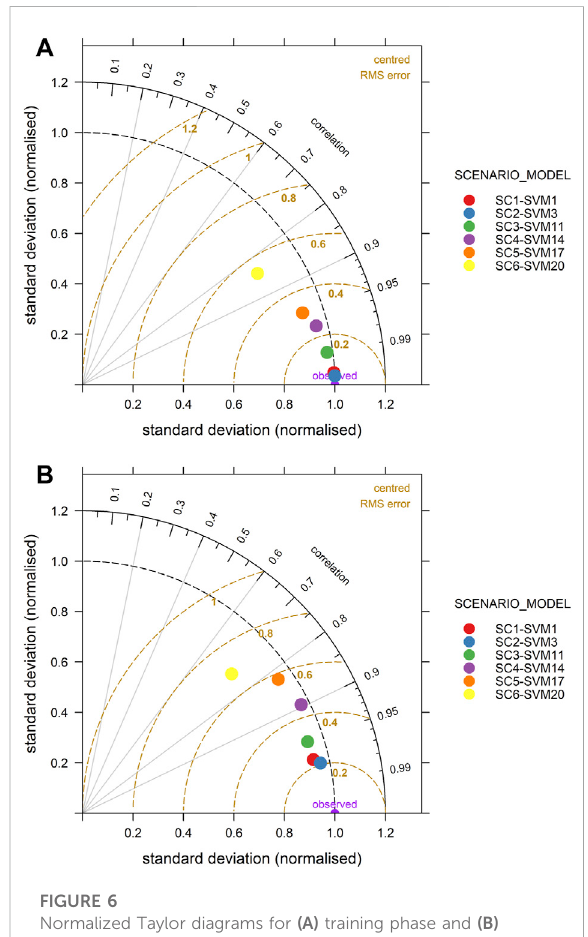
FIGURE 6 Normalized Taylor diagrams for (A) training phase and (B) testing